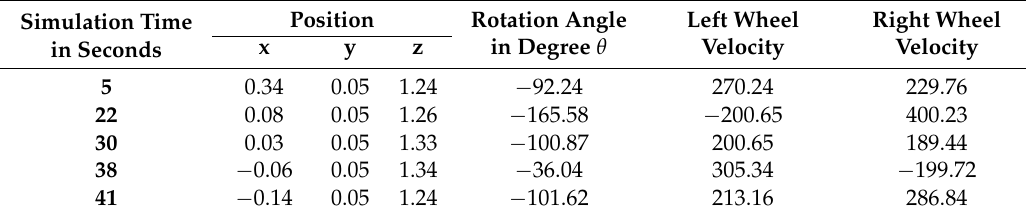
Table 5. The position, orientation, and velocities of the robot in a simple